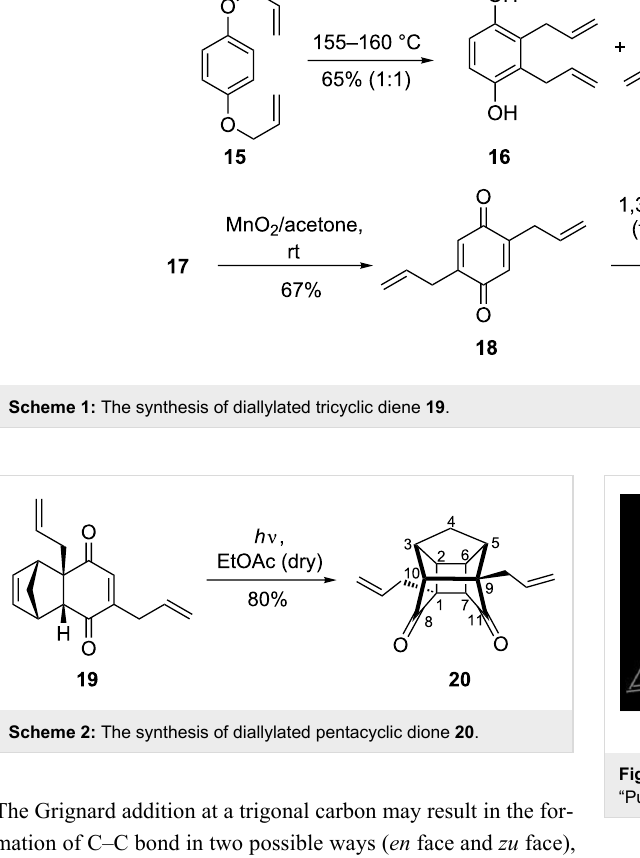
the structure was visualized with the Mercury software (Figure